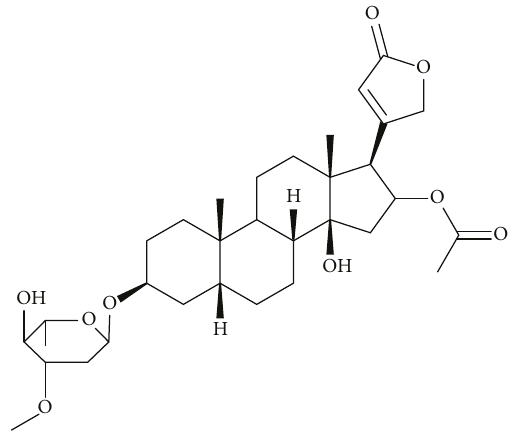
Figure 12: Chemical structure of